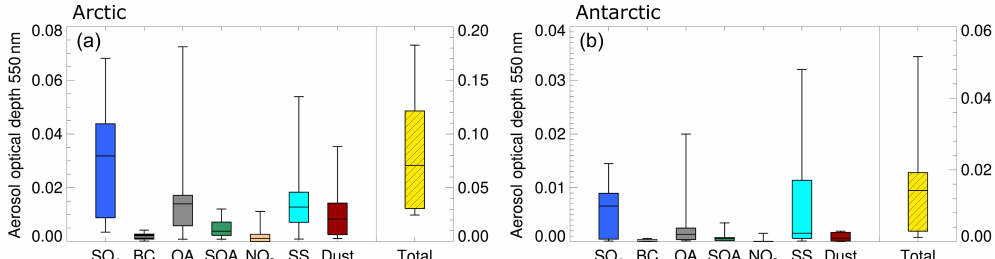
Figure 8. Annual mean multi-model median AOD for the individual components (sulfate, BC (from all sources), total OA (from all sources), SOA, nitrate, sea-salt, and dust) and the total aerosol, averaged over the Arctic (60–90 ◦ N) (a) and the Antarctic (70–90 ◦ S) (b) . The bottom and top of each box are the first and third (25th / 75th) quartiles, and the band inside the box is the model median. The whiskers represent the minimum and maximum of the model range. Note the different vertical axis – the right-hand vertical axis is for total AOD.